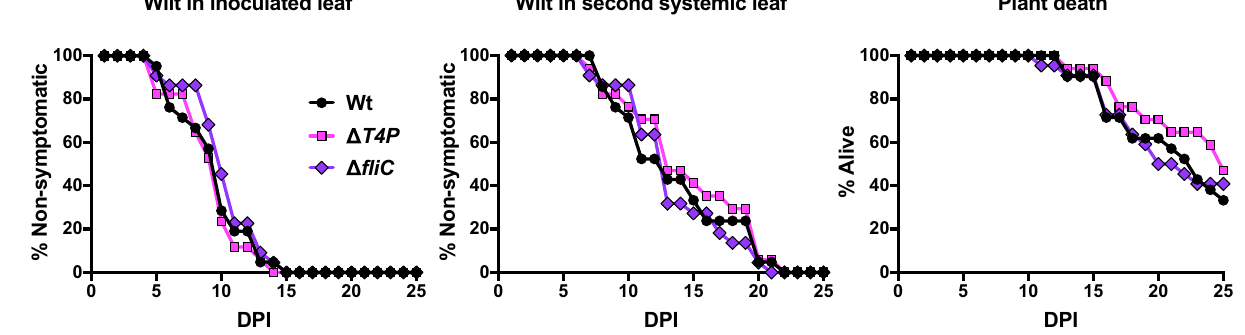
Figure 7. Comparison of virulence between wild type, flagellar deletion mutant (Δ fliC ) and Type IV Pili deletion mutant (Δ T4P ). Squash seedlings were inoculated with either Wt, Δ fliC or Δ T4P strain. Inoculated plants were monitored for first appearance of wilt symptoms in the inoculated leaf, first appearance of systemic wilt symptoms in a second non-inoculated leaf and plant death for 25 days post inoculation (DPI). Summary and statistical analyses are in Tables S4 and